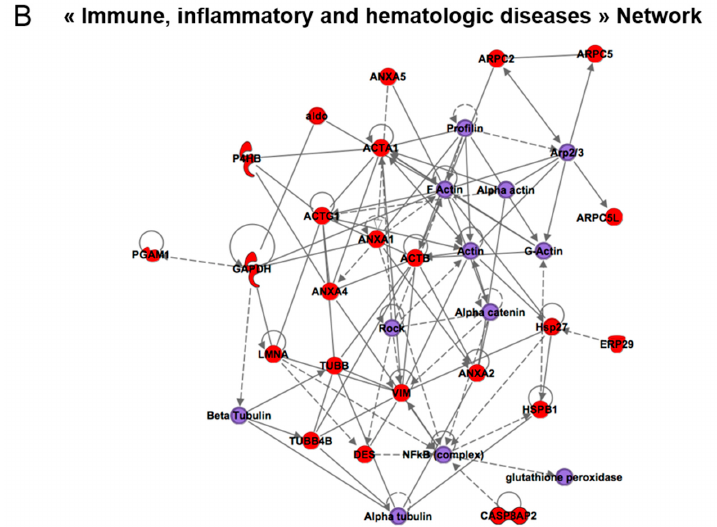
Figure 5. Figure 5. Illustration of the top networks identified by Ingenuity Pathway Analysis for the response to senescence ( A ) and selenium level variation ( B ). ACTA1: Actin, alpha skeletal muscle; ACTG1: